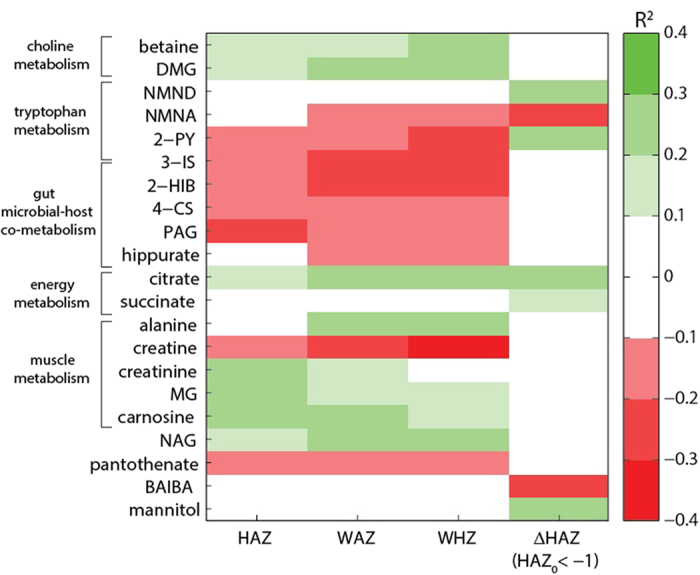
Summary of the metabolites associated with the OPLS models given by the correlation coefficient (R) with the response variable.HAZ, height-for-age z-score; WAZ, weight-for-age z-score; WHZ, weight-for-height z-score; ΔHAZ, change in height-for-age z-score over two to five months. 2HIB, 2-hydroxyisobutyric acid; 2-PY, N-methyl-2-pyridone-5-carboxamide; 3-IS, 3-indoxyl-sulfate; 4-CS, 4-cresyl sulfate; BAIBA, β-aminoisobutyric acid; DMA, dimethylamine; DMG, dimethylglycine; MG, methylguanidine; NAG, N acetylglycoprotein; NMNA, N-methylnicotinic acid; NMND, N-methylnicotinamide; PAG, phenylacetylglutamine.